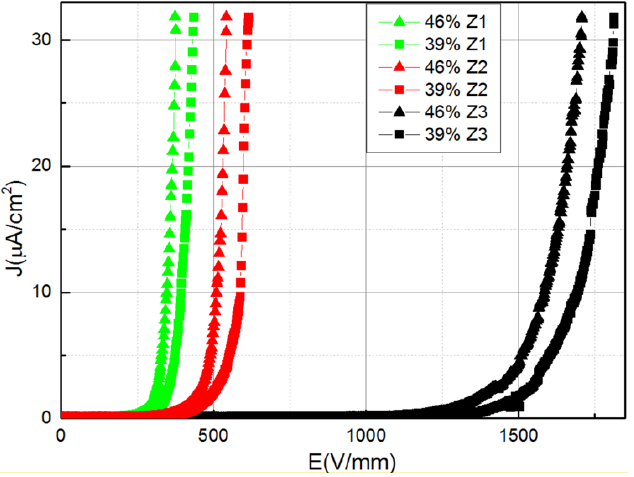
Figure 11. J–E characterization of Z1, Z2, and Z3 composites involving 46.5 vol.% and 39 vol.% filler concentration with filler diameters in the range 75–125 µ m. © 2021 IEEE. Reprinted, with permission, from [56]. Table 5. Nonlinear properties of composites involving ZnO as a filler: effect of filler size. Matrix Filler Content (vol.%) Ref.